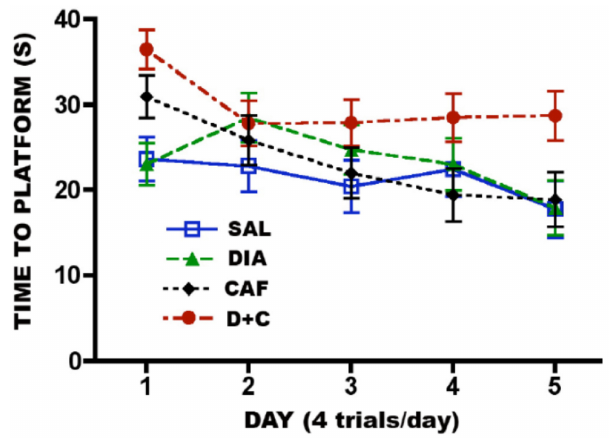
Figure 11. Latency Scores: Morris Water